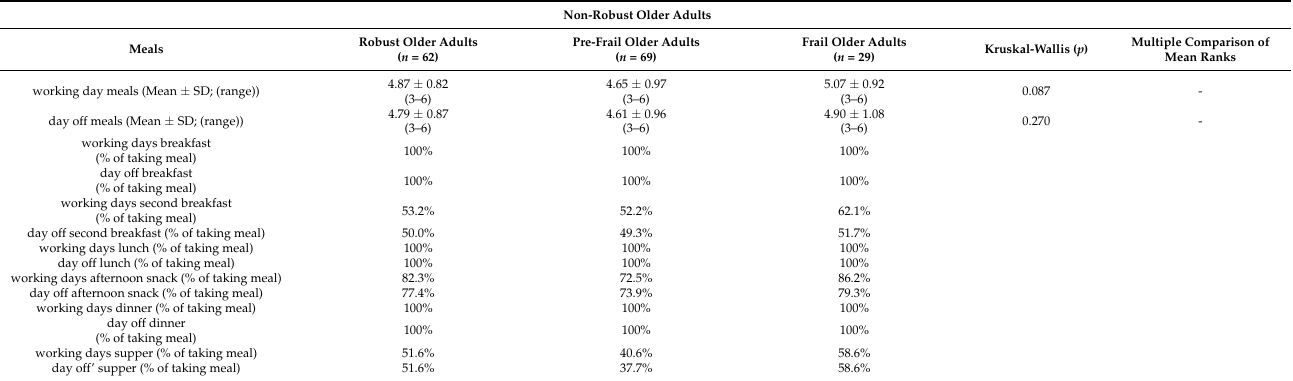
Table 6. Percentage of persons taking daily meals.